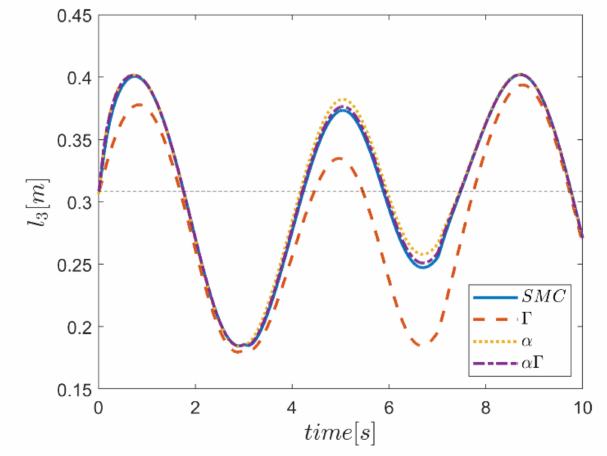
Figure 58. Comparison of the length of the third actuator.